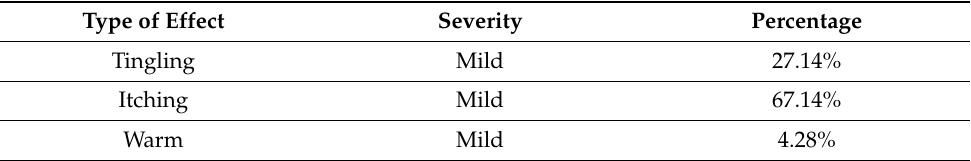
Table 2. Adverse effects, severity, and percentage of participants that experienced them in the tDCS study.